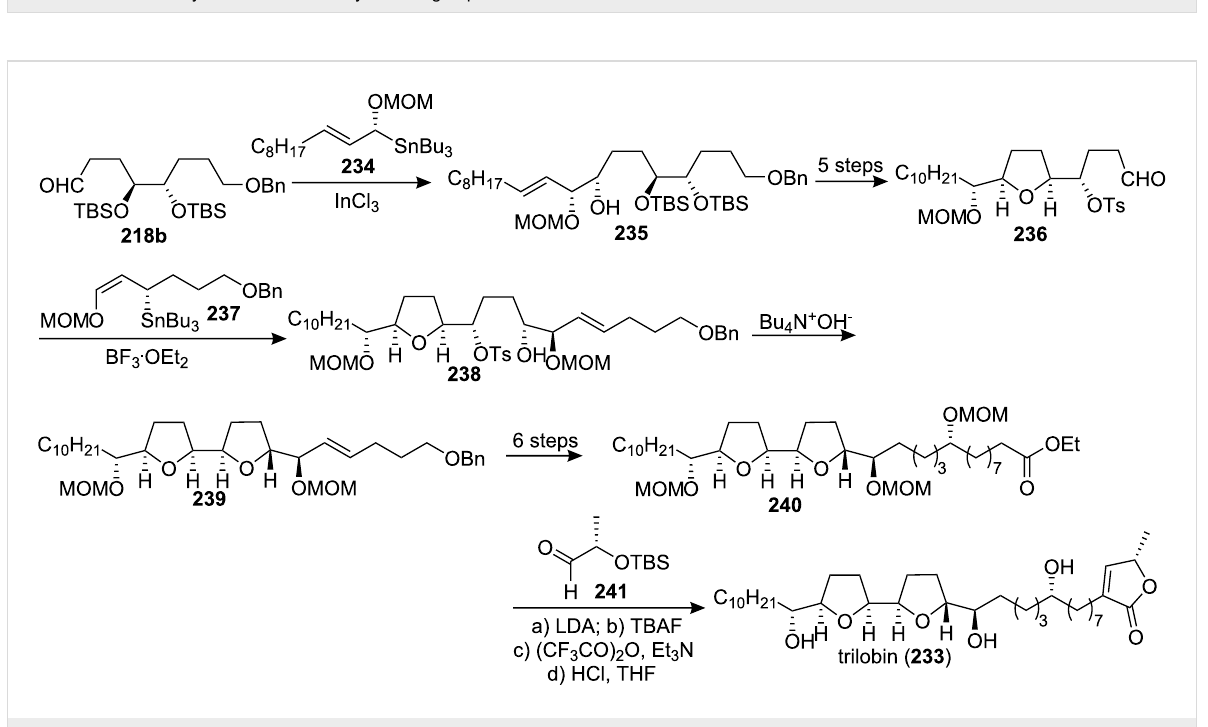
Scheme 32: Total synthesis of trilobin by Marshall’s